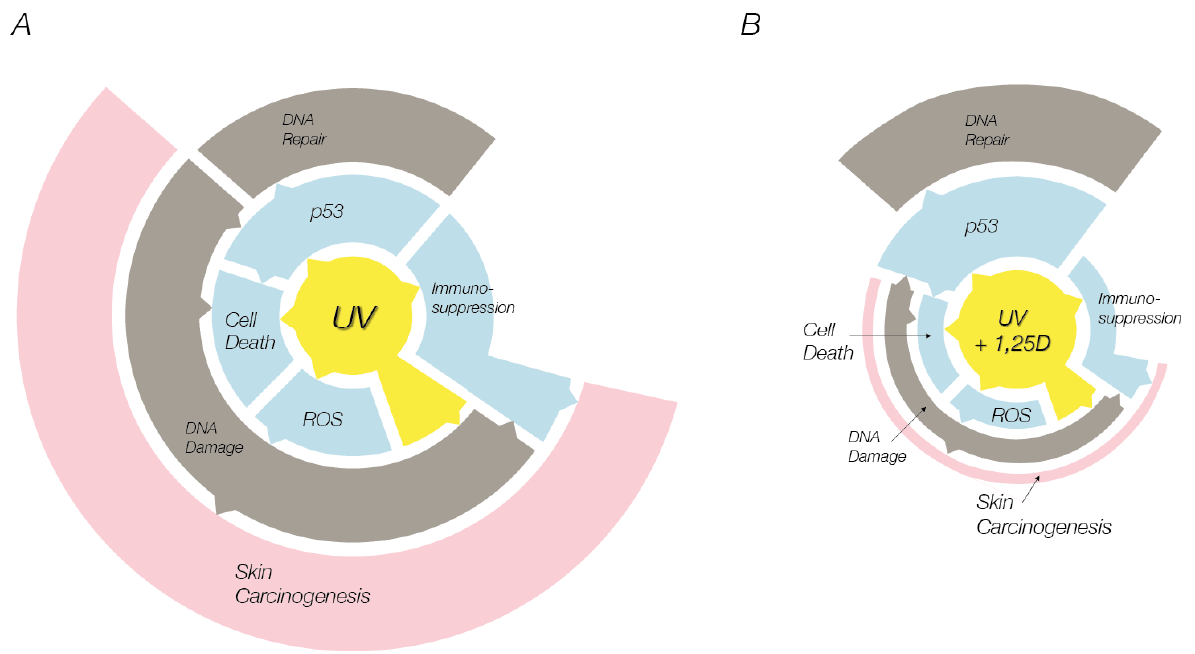
Figure 2. ( A ) Mechanisms of skin carcinogenesis due to ultraviolet (UV) radiation. UV causes cell death through p53-dependent and -independent mechanisms. p53 may facilitate DNA repair or can induce apoptosis of irreparably damaged cells. UV also causes DNA damage directly via absorption and indirectly via formation of reactive oxygen species. UV and DNA damage can lead to immunosuppression. Together, DNA damage and immunosuppression can initiate skin carcinogenesis; ( B ) Proposed mechanism for protection against skin carcinogenesis by 1,25D. The sizes of segments indicate reductions and increases caused by 1,25D. Vitamin D compounds can inhibit UV-induced cell death, DNA damage, immunosuppression and skin carcinogenesis. This may involve the ability of vitamin D compounds to further increase p53 after UV, thereby facilitating DNA